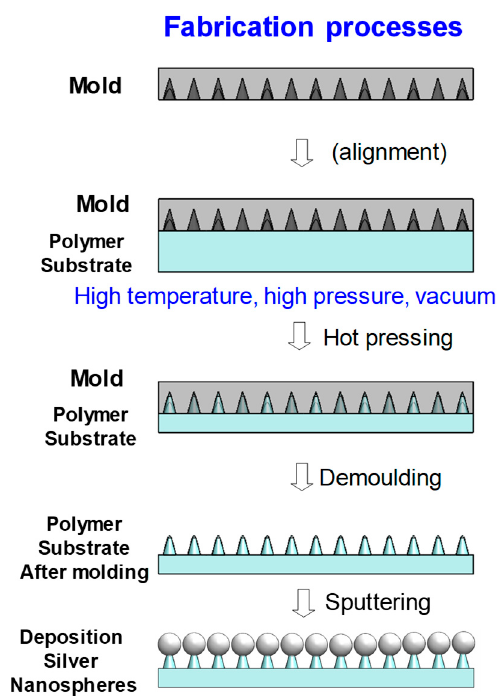
Figure 1. Schematic illustration of the fabrication processes. The nanostructured mold was pressed on a Polycarbonate (pc) plastic substrate using a hot-press molding machine. The nanostructured-nickel mold was heated and pressed on the pc surface for several minutes. After cool down to room temperature, the pc substrate with replicated nanostructure was released from the master mold.